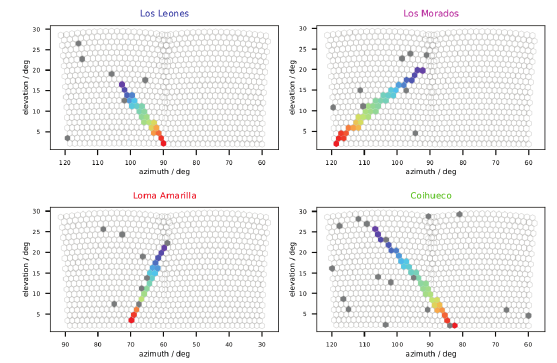
Figure 4. The camera views at the four sites where the event PAO100815, #84, was detected. The colors (violet to red) repre- sent the time (early to late) at which the light reaches each pixel. Dark grey pixels indicate pixels that were triggered